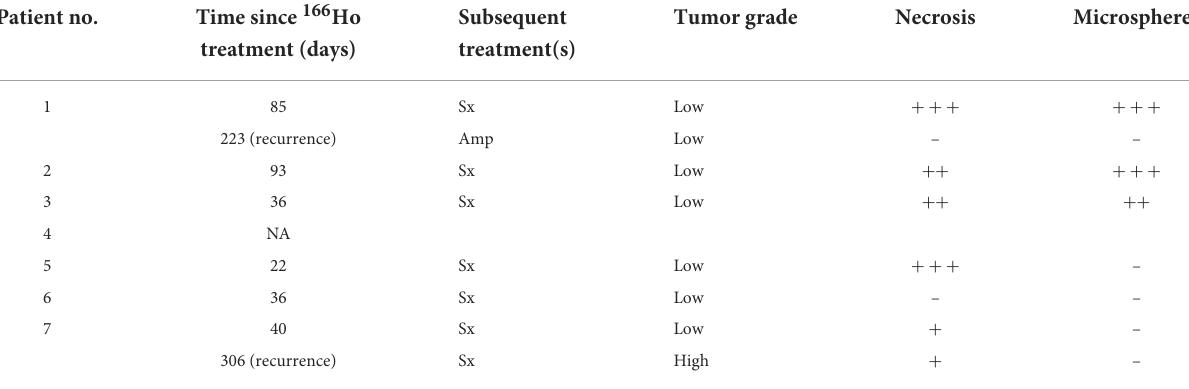
TABLE 3 Histopathologic findings of resected tumor tissue following holmium-166 ( 166 Ho) microbrachytherapy of seven canine patients with soft tissue sarcoma. Patient no.